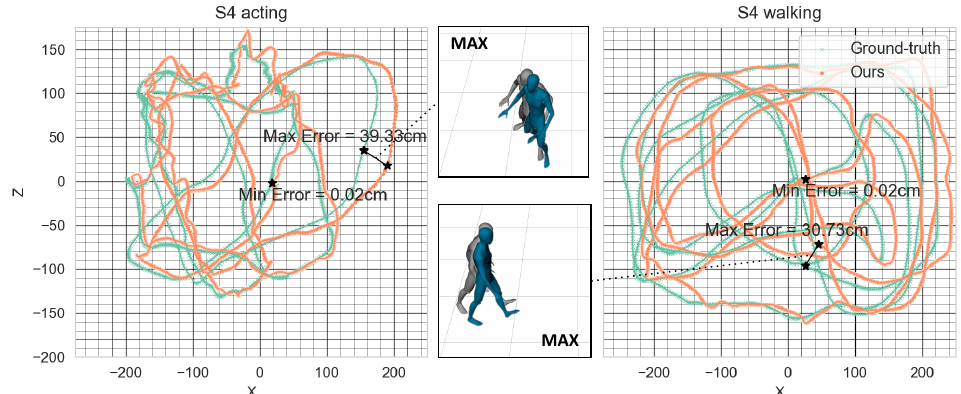
Figure 8. The trajectory of S4 (Subject 4) from the TotalCapture dataset. The overlapping frames in the middle of figure show the maximum value of the location tracking error in each motion sequence.